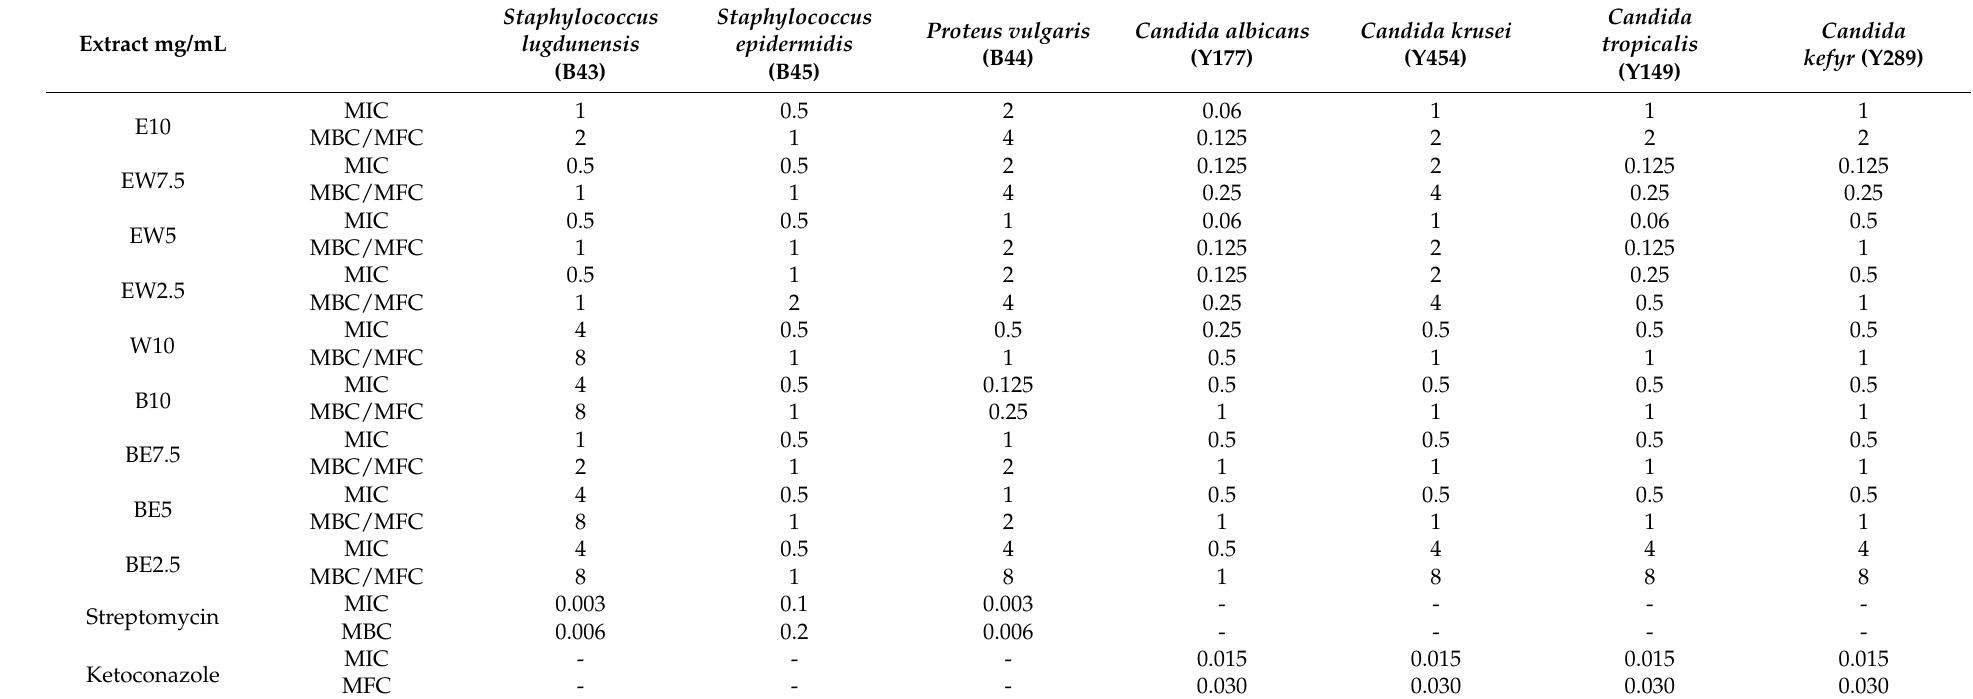
Table 4. Antimicrobial activity of different Allium scrorodoprasum flower extracts in mg/mL.